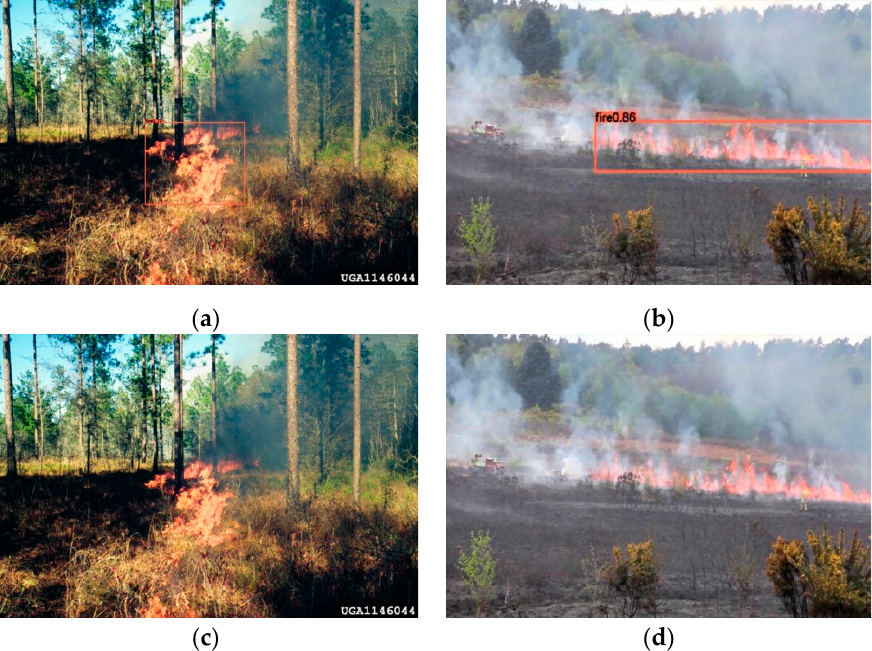
Figure 5. ( a ) True positive predictions generated by Yolov5; ( b ) True positive predictions generated by Yolov5; ( c ) EfficientDet false positive prediction; ( d ) EfficientDet-generated false positive prediction.